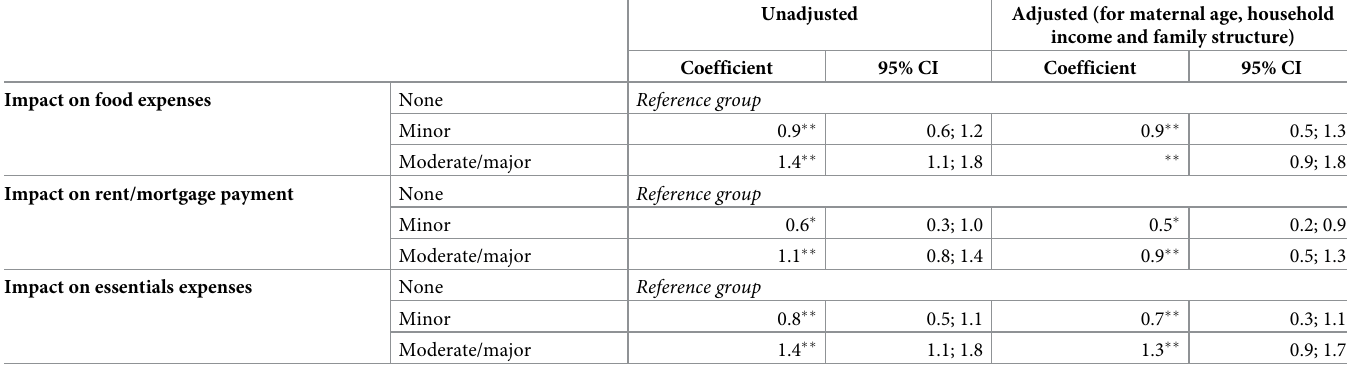
Table 6. Regression of COVID-19 pandemic impact on ability to pay for household expenses by maternal psychosocial wellbeing a in the UK COVID-19 New Mum Study (28 th May 2020-26 th June 2021; N = 1134).